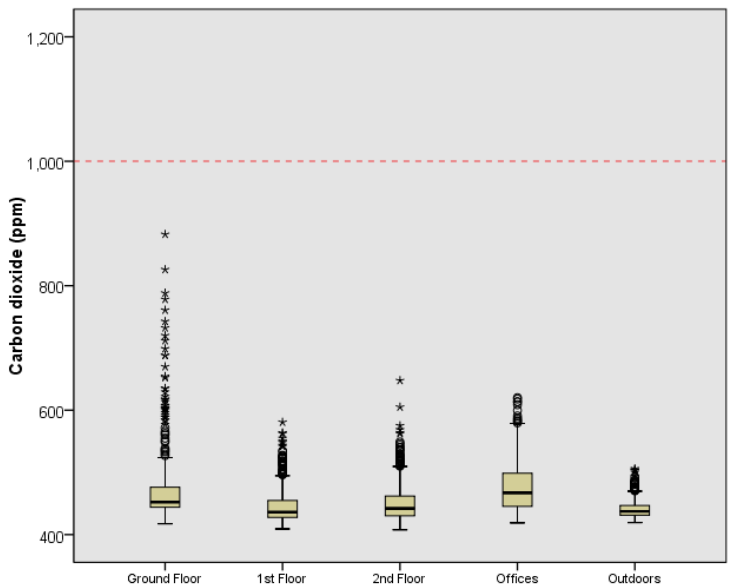
Figure 6. Carbon dioxide concentrations in the museum halls and outdoors. ‘’*” symbol is used for the outliers.